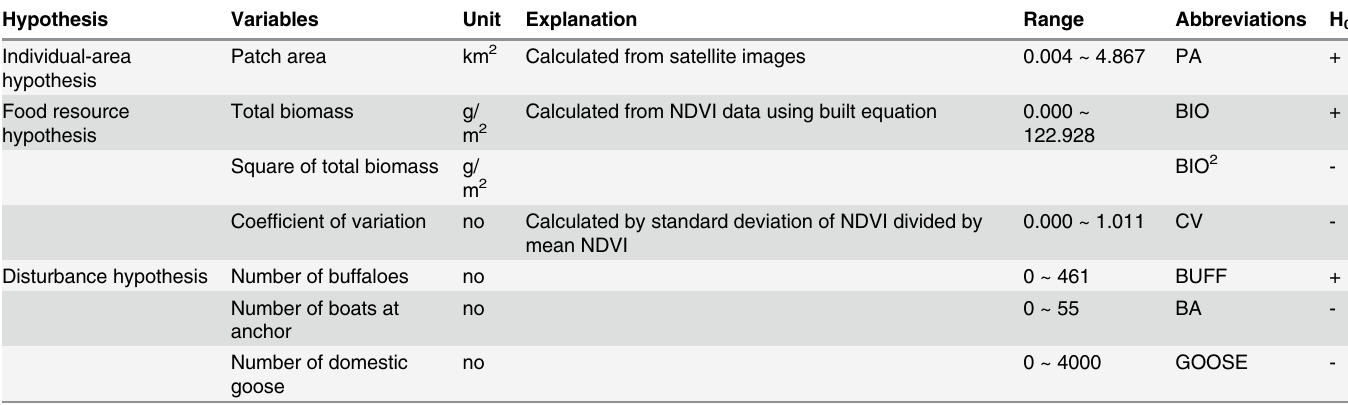
Table 1. The potential predictor variables and their abbreviations used to analyse differences in goose densities. H 0 indicates expected relationship. +: positive; -: negative. NDVI: Normalized Difference Vegetation Index.